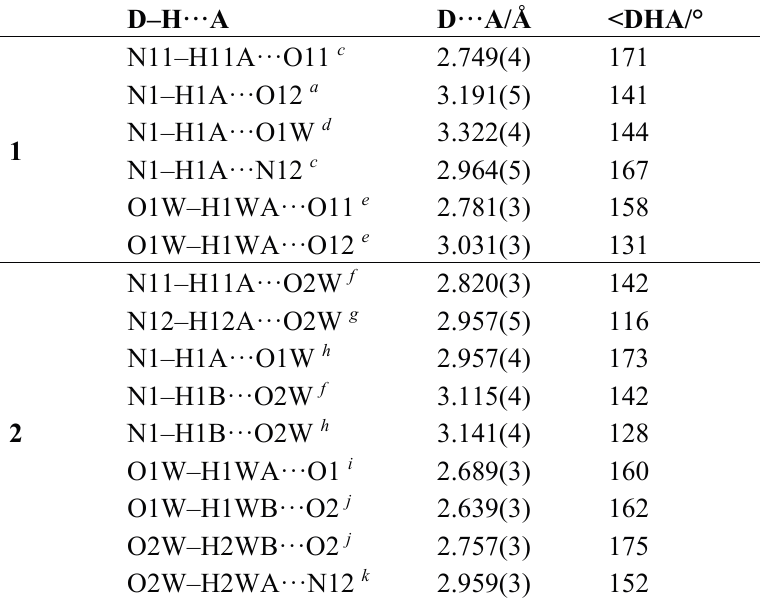
Table 2. Hydrogen-bonding geometrical details for the interactions present in the crystal structures of [Zn(Hatrc) 2 (H 2 O)] ( 1 ) and [Mn(Hatrc) 2 (H 2 O) 2 ]·2H 2 O ( 2